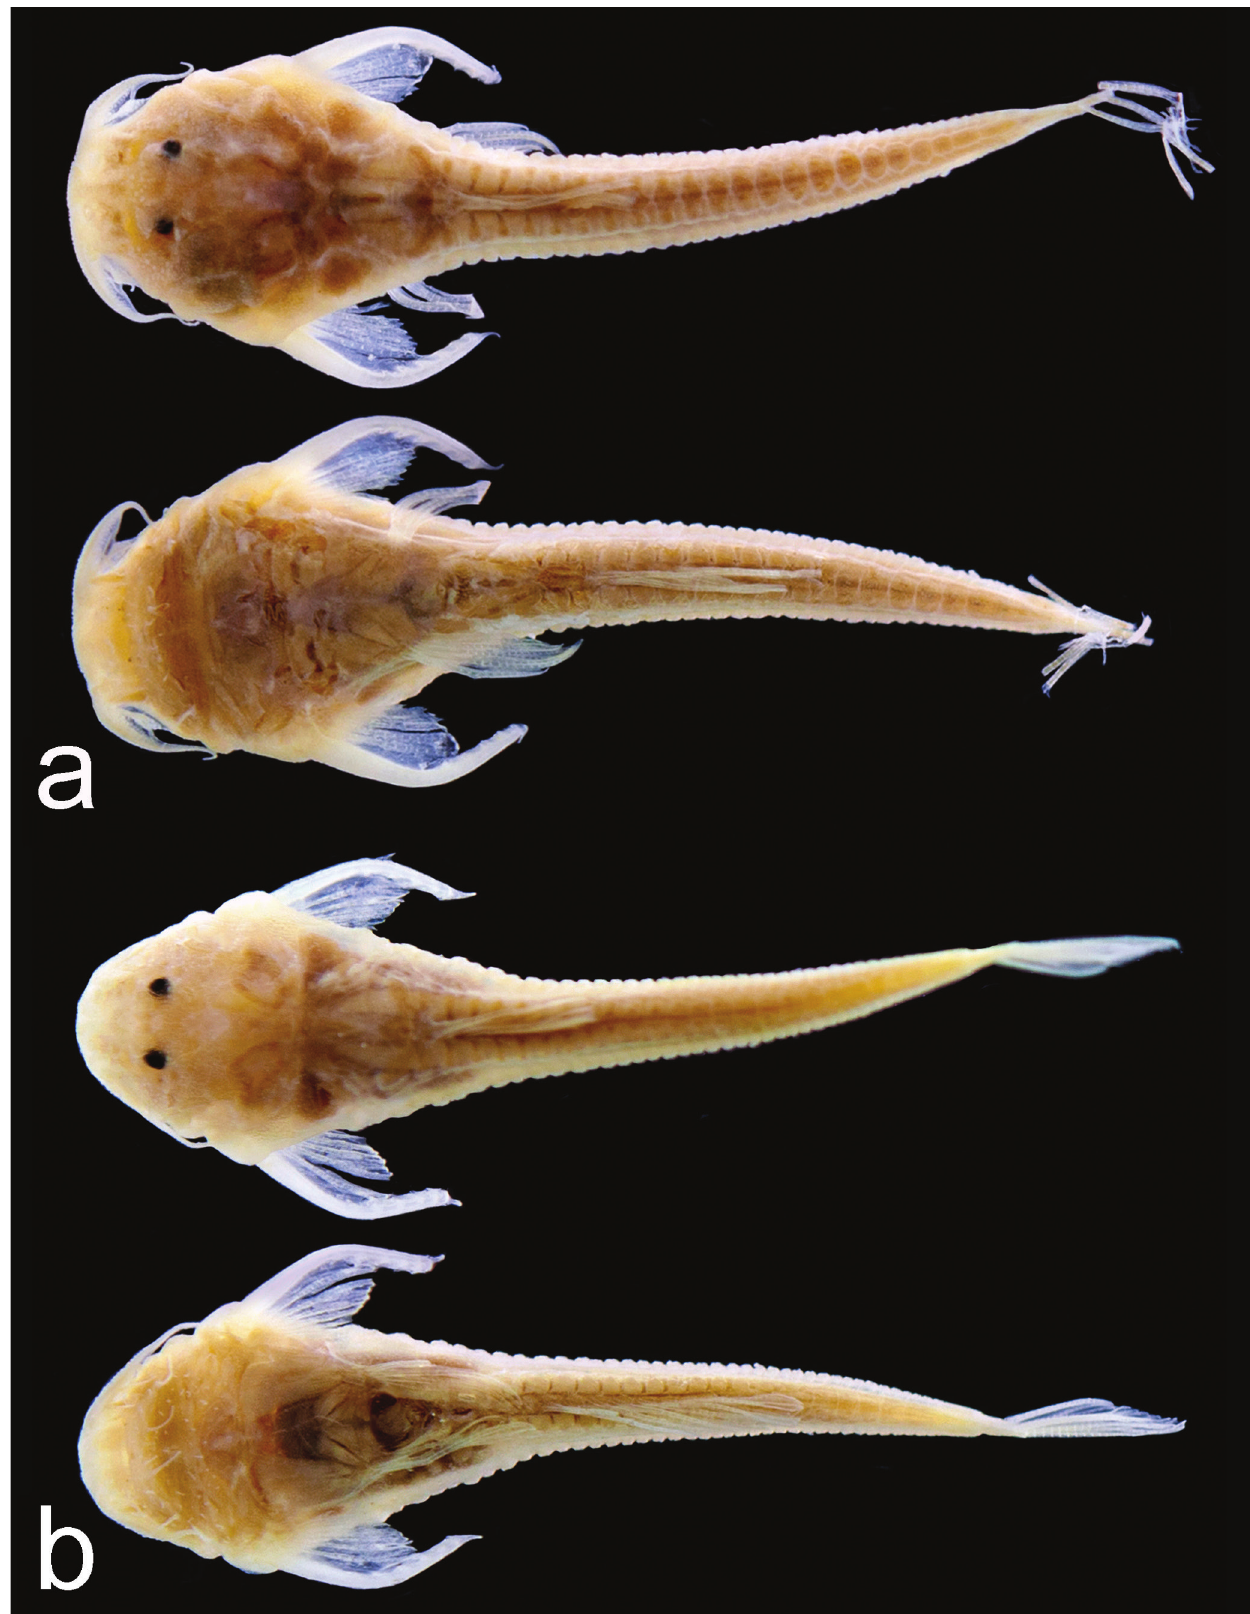
Fig. 2. Hoplomyzon cardosoi , paratypes in dorsal and ventral views. a. MCNG 26955, 15.1 mm SL. b. MCNG 11560, 15.7 mm